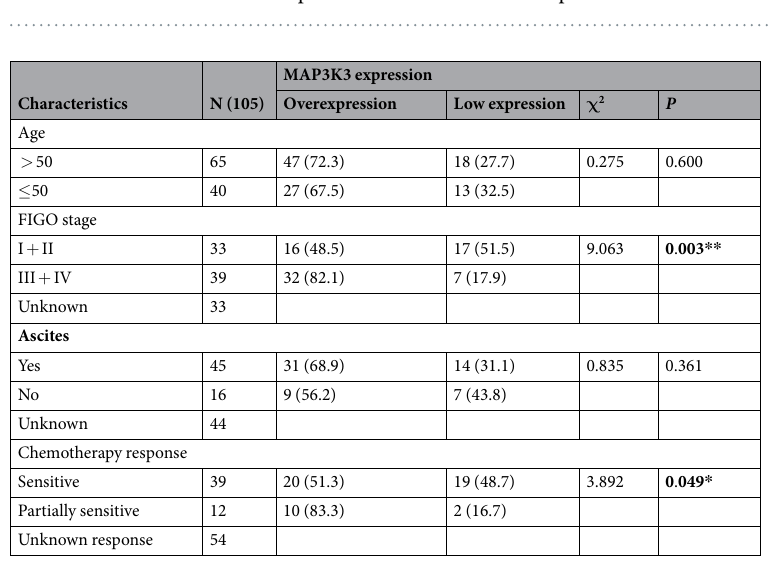
Table 1. Profiles of MAP3K3 expression in HGSOC and fallopian tube.